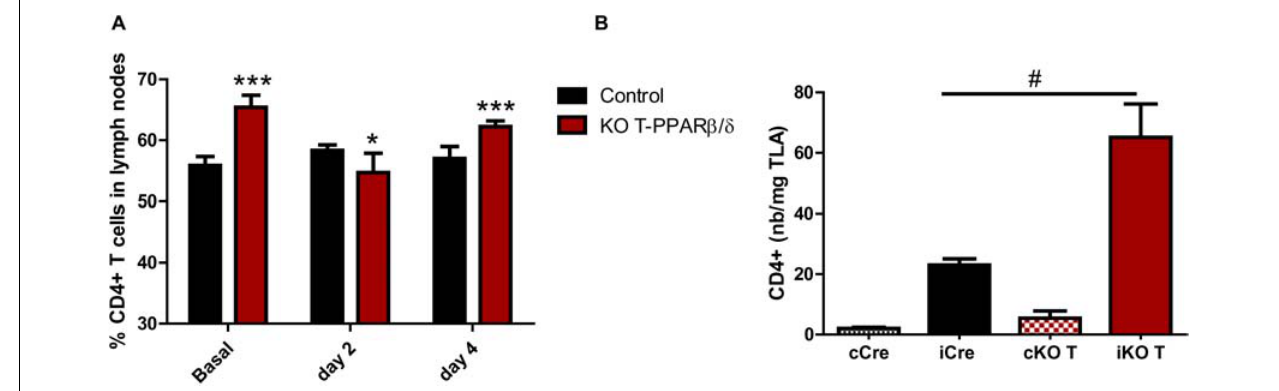
FIGURE 2 | CD4 + T cell prevalence in lymph nodes and in TLA after cardiotoxin-induced injury of young KO-T PPAR β / δ and control mice. (A) CD4 + T cell prevalence in lymph nodes . Percentages of CD4 + T cells among CD3 + cell population in basal state and at day 2 ( n = 5 per group) and day 4 (control, n = 8; KO-T PPAR β / δ , n = 6) after injury of TLA with cardiotoxin. (B) CD4 + T cell number in TLA . Number of CD4 + T cells among CD3 + T cell population (expressed per mg of TLA) in cells from digested TLA 2 days after injury with cardiotoxin. Left TLA of each mouse was injured and the right TLA of the same mice was injected with saline (cCre: uninjured TLA (right) of control Cre mice; iCre: injured TLA (left) of control Cre mice; cKO T: uninjured TLA (right) of KO-T PPAR β / δ mice; iKO T: injured TLA (left) of KO-T PPAR β / δ mice). Values are mean ± SD. Statistical analysis was performed using two-way (time post-injury and genotype) analysis of variance (ANOVA) test. Interaction effect between time post-injury and genotype was significant.* p < 0.05, *** p < 0.0005 different from control mice at the same time (basal, day 2, day 4); # p < 0.05 interaction effect between genotype and injury.